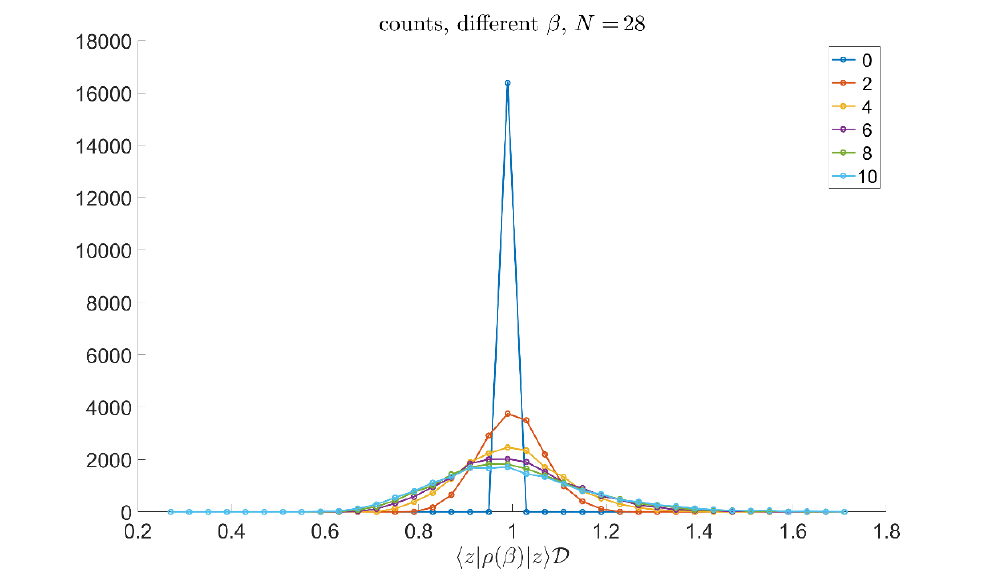
Figure 18 . Histogram of h s; (cid:12) j s; (cid:12) i for N = 28 Majorana fermions in a single SYK cluster ( L = 1). The di(cid:11)erent curves correspond to (cid:12) = 0 ; (cid:1) (cid:1) (cid:1) ; 10 in units with J 0 = 1. There is a strong concen- tration around the value predicted by the random model studied